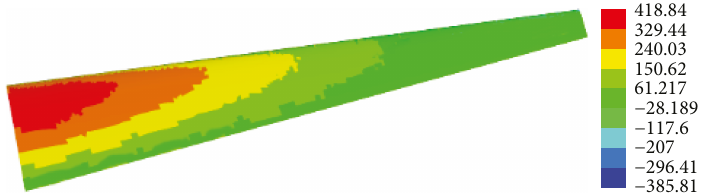
Figure 46: Stress cloud diagram of the lower wing with the layer ratio being 20%/20%/60%.